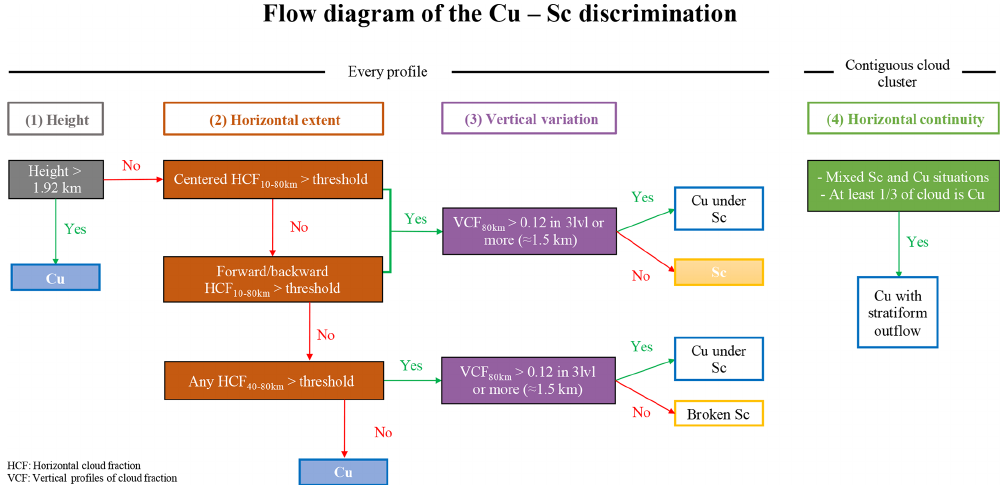
Figure 2. Flow diagram of the algorithm that performs the Sc–Cu discrimination. The gray, orange, purple and green colors represent the different steps of the discrimination algorithm to separate Sc, broken Sc, Cu, Cu under Sc and Cu with stratiform outflow clouds: height, horizontal extent, vertical extent and horizontal continuity, respectively. The choice of HCF thresholds is discussed in Sect. 3.3 and their values are shown in Fig. 4. The VCF threshold (0.12) and the horizontal continuity test are also explained in Sect. 3.4 and further used in Fig. 5. Note that the steps 1 to 3 are applied to every profile while the step 4 is only applied to contiguous cloud clusters.